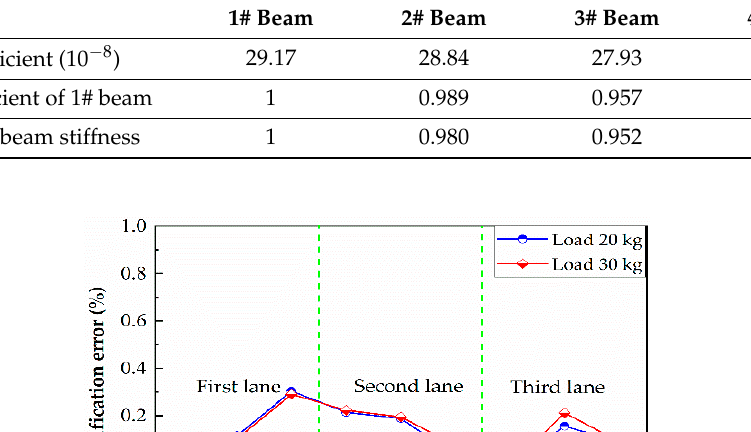
Table 2. The mid-span strain integral coefficient of each beam bottom.